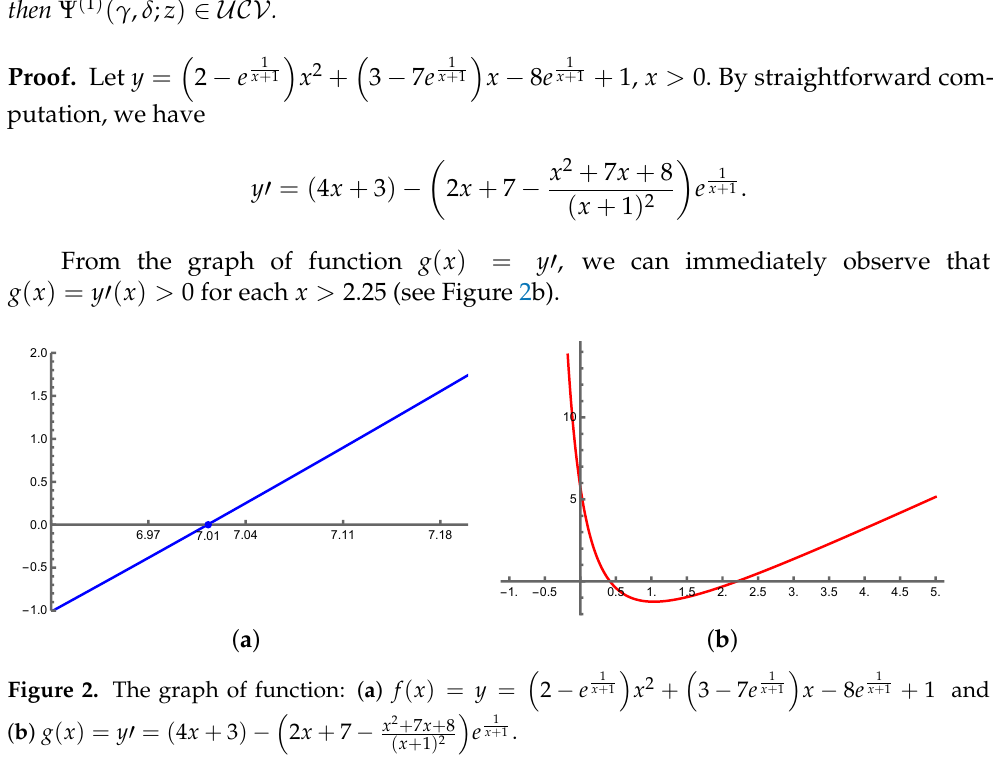
(cid:16) (cid:17) (cid:16) (cid:17) x 2 + x − 8 e 1 x + 1 + 1 and 2 − e 1 x + 1 3 − 7 e 1 x + 1 (cid:16) (cid:17) e 1 x + 1 . 2 x + 7 − x 2 + 7 x + 8 ( x + 1 ) 2